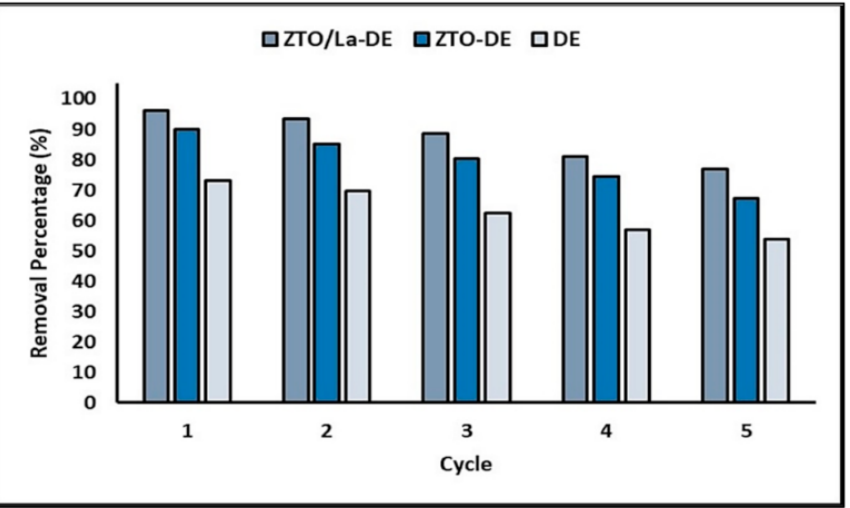
Figure 12. Percentage of MB removal during five successive adsorption–photocatalysis